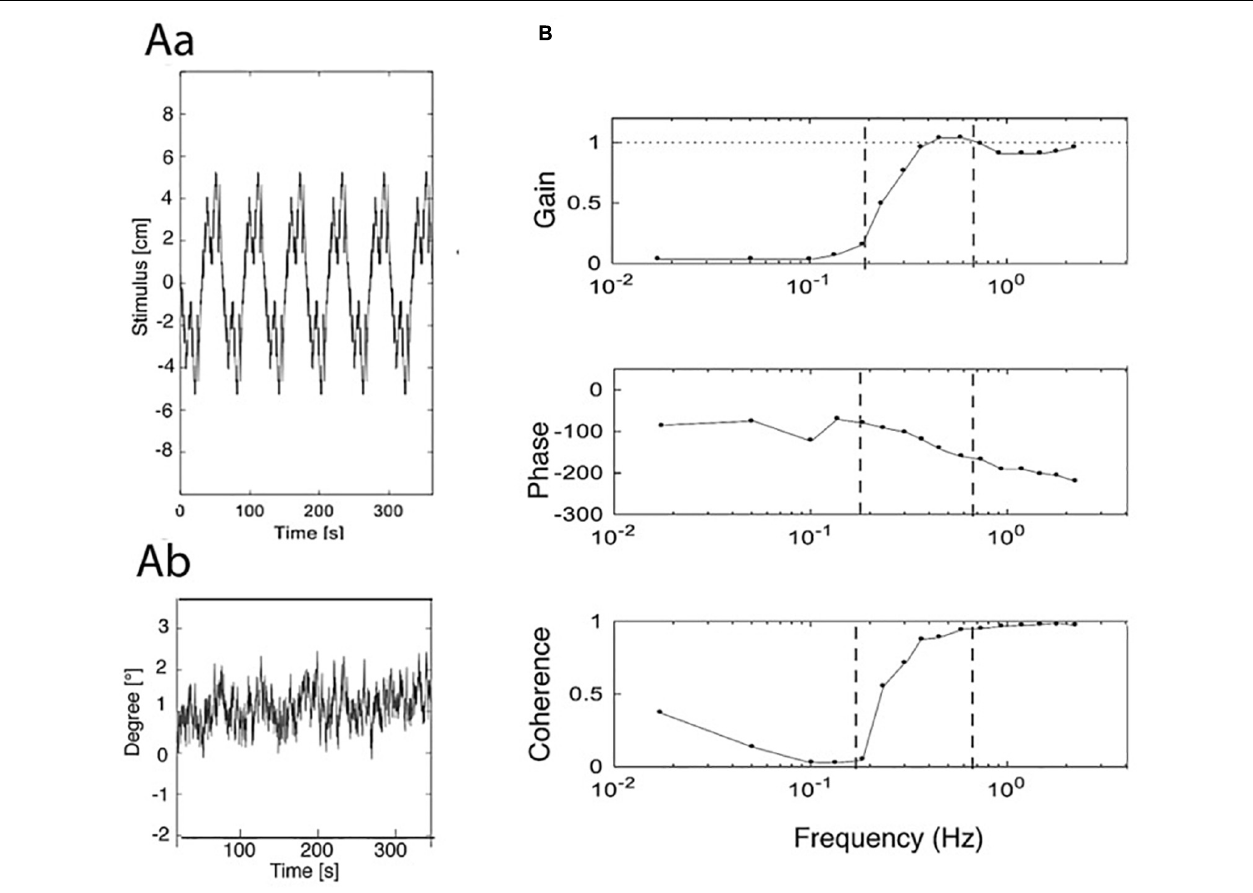
FIGURE 1 | Examples of stimulus, original response, and frequency response functions (FRFs). (Aa) PRTS translation stimulus (pp. 9.6 cm). (Ab) Evoked sway response of body COM around ankle joints (eyes closed). (B) Derived frequency response functions (FRFs) of gain, phase, and coherence. Vertical dashed lines separate low, middle, and high-frequency ranges of the stimulus; compare Figure 2 ). Gain represents the amplitude ratio between sway response amplitude and translation stimulus amplitude. Unity gain indicates a response of 1 ◦ sway amplitude per 1 cm of support translation and zero gain the absence of any evoked sway. Phase reflects the temporal relation between the translation stimulus and the sway response (0 ◦ indicating exactly in-phase response and –180 ◦ a lean counter to platform translation). Coherence is a measure of the signal to noise ratio of the stimulus-evoked sway (the coherence for a linear ideal system with no noise would be unity over the whole spectrum). To get an impression of the stimulus, see